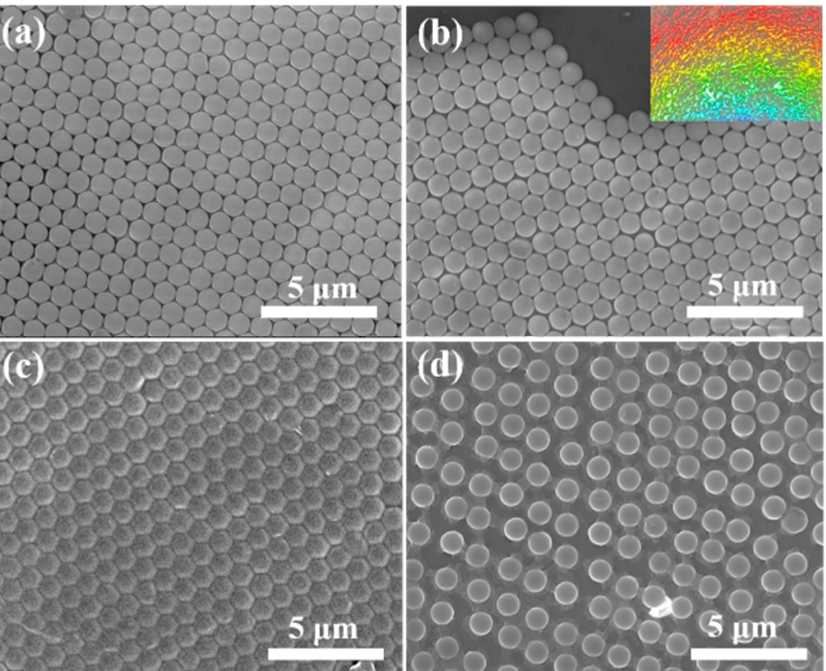
Figure 3. ( a , b ) SEM images of 2DPC array prepared from ~960 nm of PS microspheres on glass slide; Inset in ( b ) a photograph of the 2DPC array taken under illumination with a flashlight below at an angle of ~75 ◦ to the normal. The PS microspheres arrange orderly and closely on the glass slide and form a 2D monolayer array with a vivid rainbow color. ( c ) SEM image of the 2DPC hydrogel prepared initially. ( d ) SEM image of the 2DPC hydrogel equilibrated in PBS solution. The PS microspheres are still close-packed for the freshly prepared 2DPC hydrogel, while they become non-close-packed after equilibration in PBS solution due to the swelling of the hydrogel.